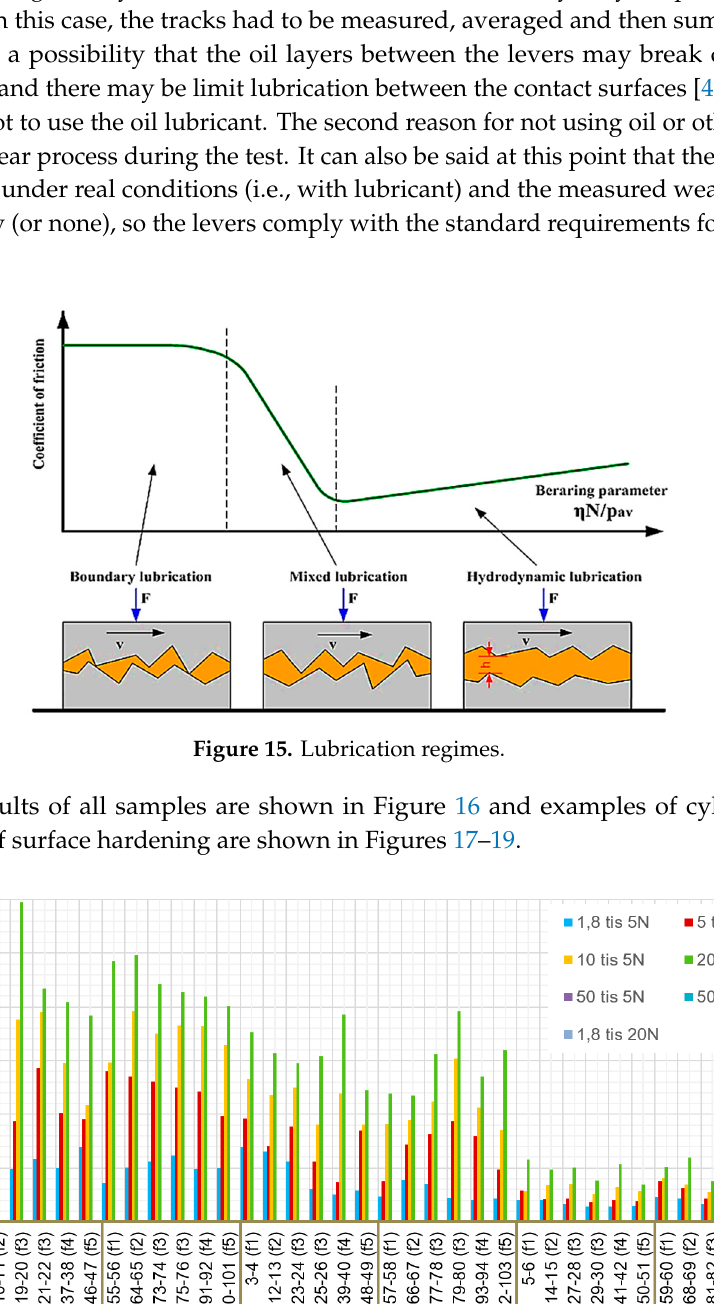
Figure 17. Sample No. 11—20× magnification, 1.8 × 103 cycles of 5 N load ( left ); Sample No. 55—10× magnification, 5 × 103 cycles, 5 N load ( right ).